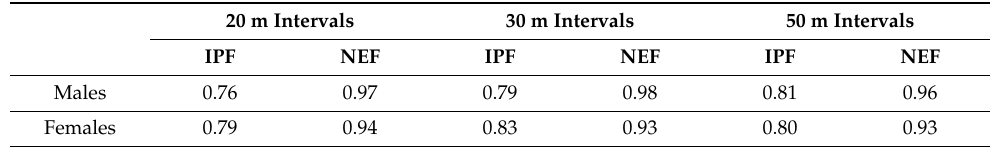
Table 2. Stability index (R 2 ) of the inverse power function (IPF) and the negative exponential function (NEF) based on calculations with 20, 30 and 50 m intervals of the covered distances of Erebia pronoe